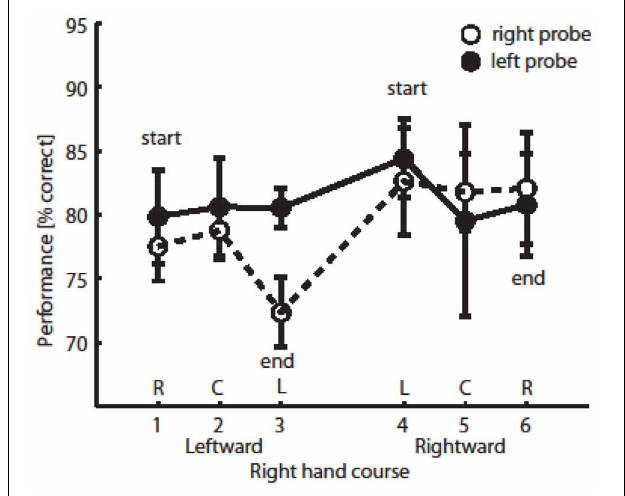
FIGURE 2 | Probe discrimination performance. Performance on trials with right probe location (open circles) or left probe location (full circles), depending on hand position (x-axis, proportional to time on trial). Each circle denotes average performance (with